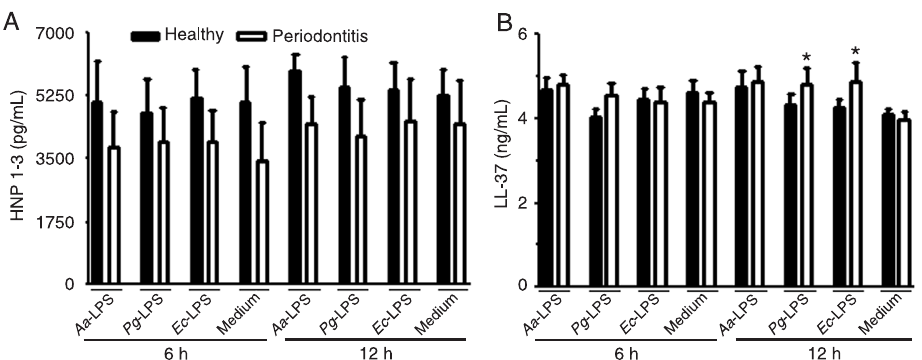
Figure 2. HNP 1-3 and LL-37 production by peripheral neutrophils. Neutrophils were incubated for 6 and 12 h with culture medium only or with medium containing Aa -LPS (100 ng/mL), Pg -LPS (100 ng/mL) or Ec -LPS (100 ng/mL), and production of HNP 1-3 ( A ) and LL-37 ( B ) was determined by ELISA. Data are reported as means ± SD for N = 6 in each group. *P ≤ 0.05, periodontitis compared to healthy subjects (Student t -test). For abbreviations, see legend to Figure